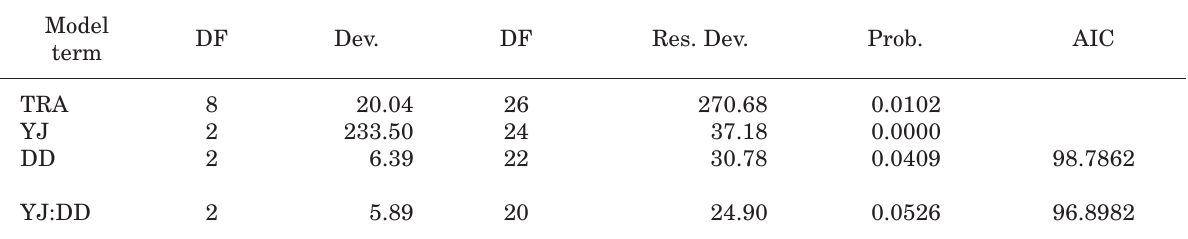
Table 1. Analysis of deviance. Terms are added sequentially (first to last). The Table shows, from left to right: name of the model term, its degree of freedom (DF), its deviance (Dev.), the degree of freedom (DF) of the residual devi- ance, its value (Res. Dev.), and the probability associated to the observed test statistic. Finally, the AIC value for the two models used is also shown.